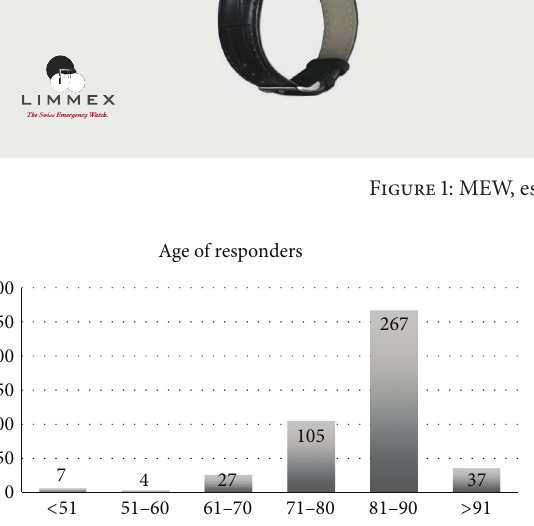
Figure 2: Age of responders to the survey.